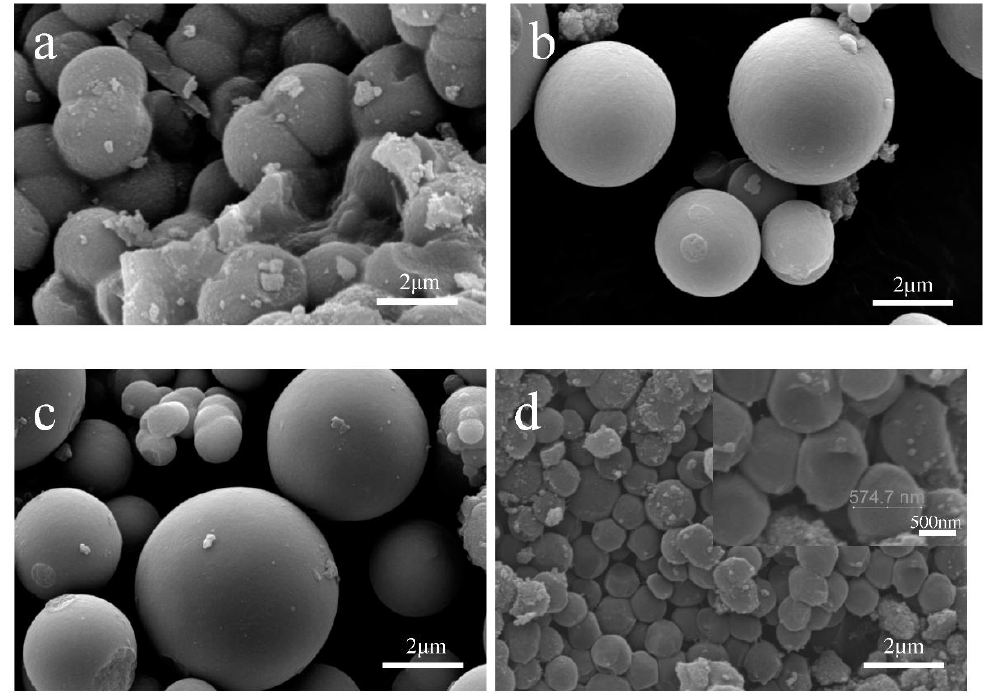
Figure 1. Field Emission Scanning Electron Microscopy (FESEM) images of Ms prepared with different amounts of HCl: ( a ) 0 mL; ( b ) 0.03 mL; ( c ) 0.43 mL and ( d ) 1.50 mL.